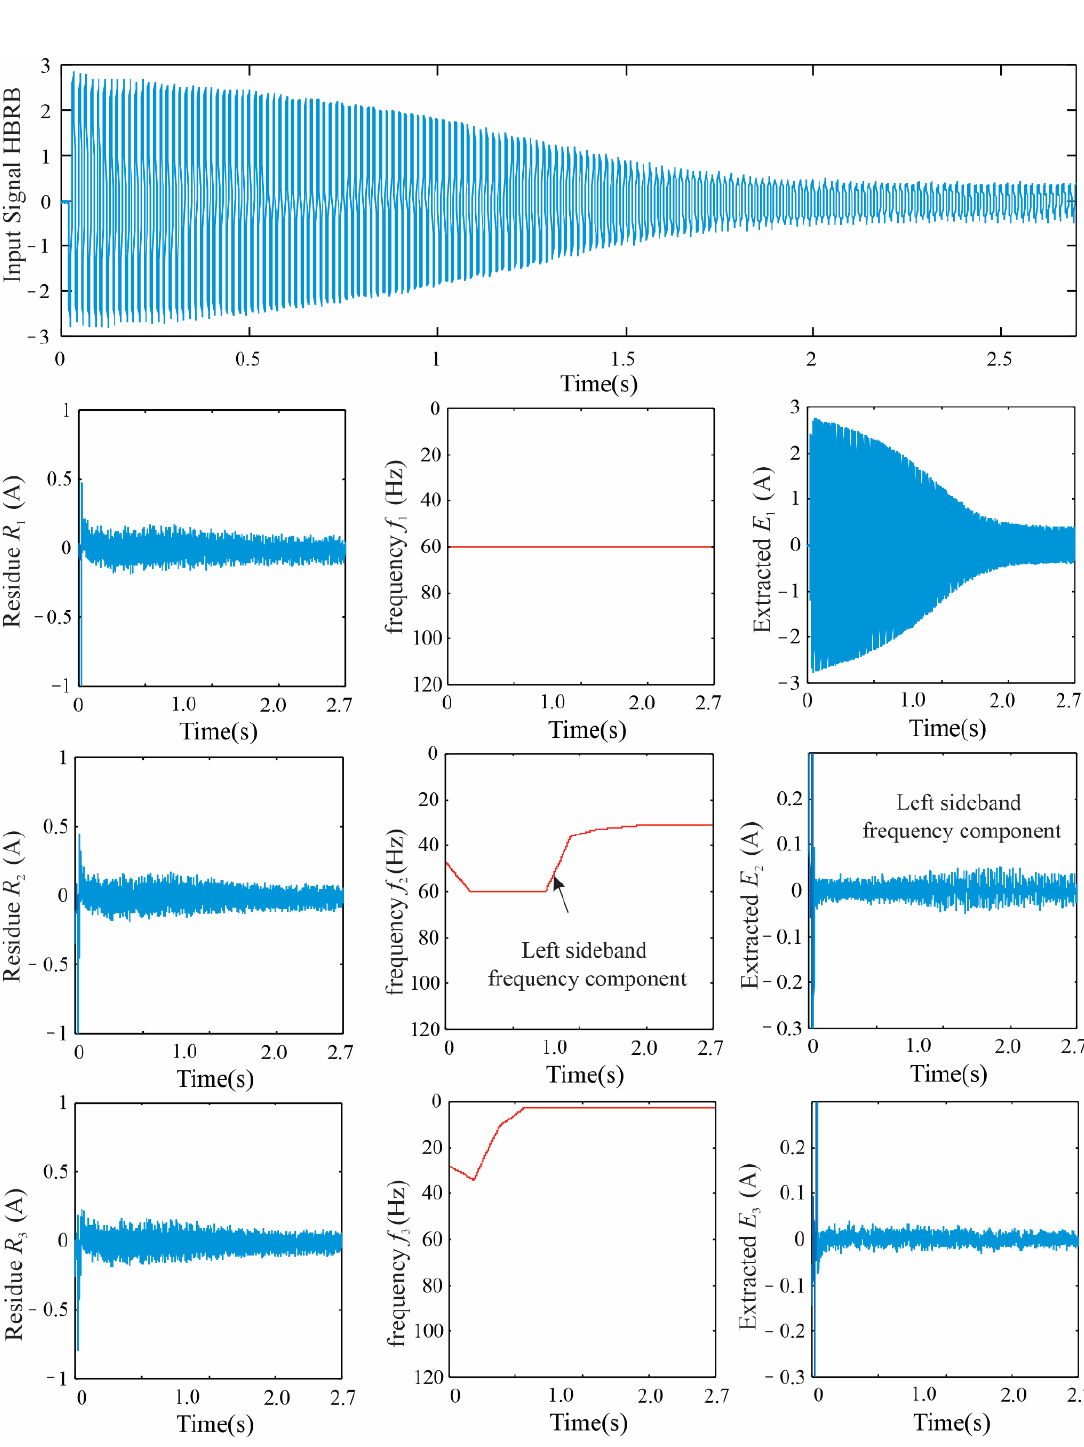
Figure 11. FBASD output for the HBRB case.